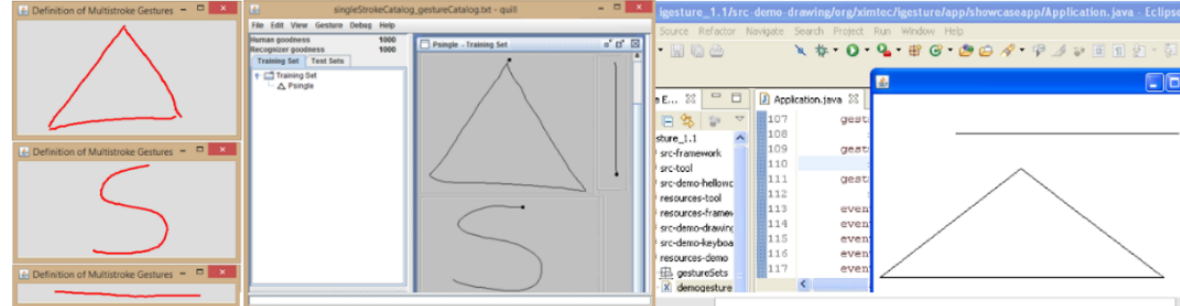
Figure 16. Examples of multi-stroke gestures: $N (left) and quill (centre) and iGesture (right)